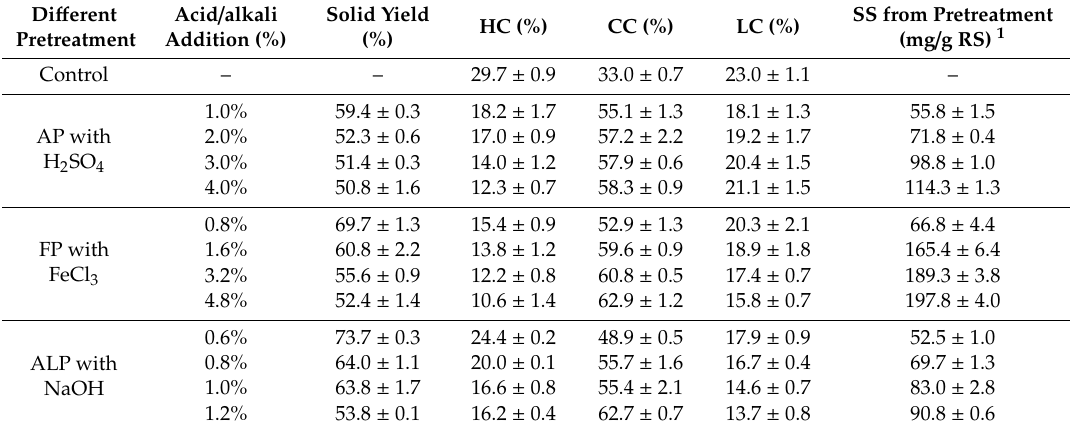
Table 1. E ff ect of dilute acid pretreatment (AP), ferric chloride pretreatment (FP), dilute alkaline pretreatment (ALP) of Arundo donax L. on its chemical